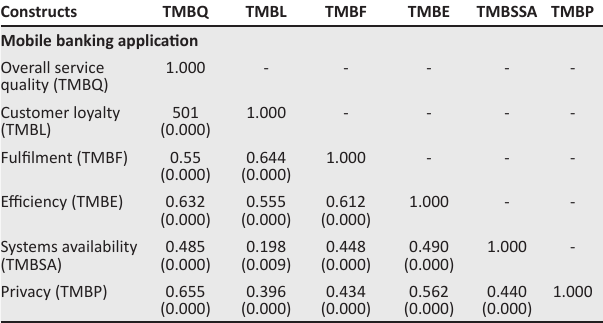
TABLE 3b: Pearson correlation coefficient results of Unstructured Supplementary Service Data